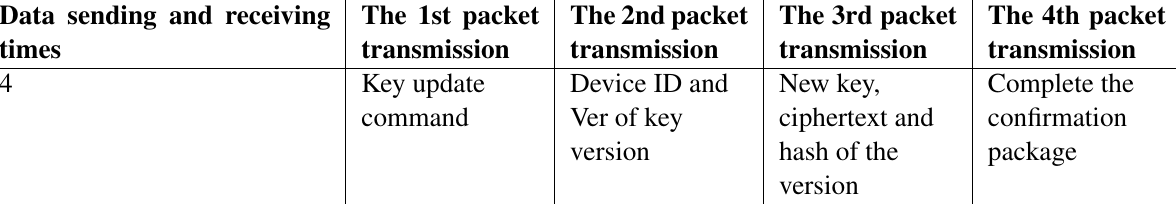
Table 3 Communication overhead of key update